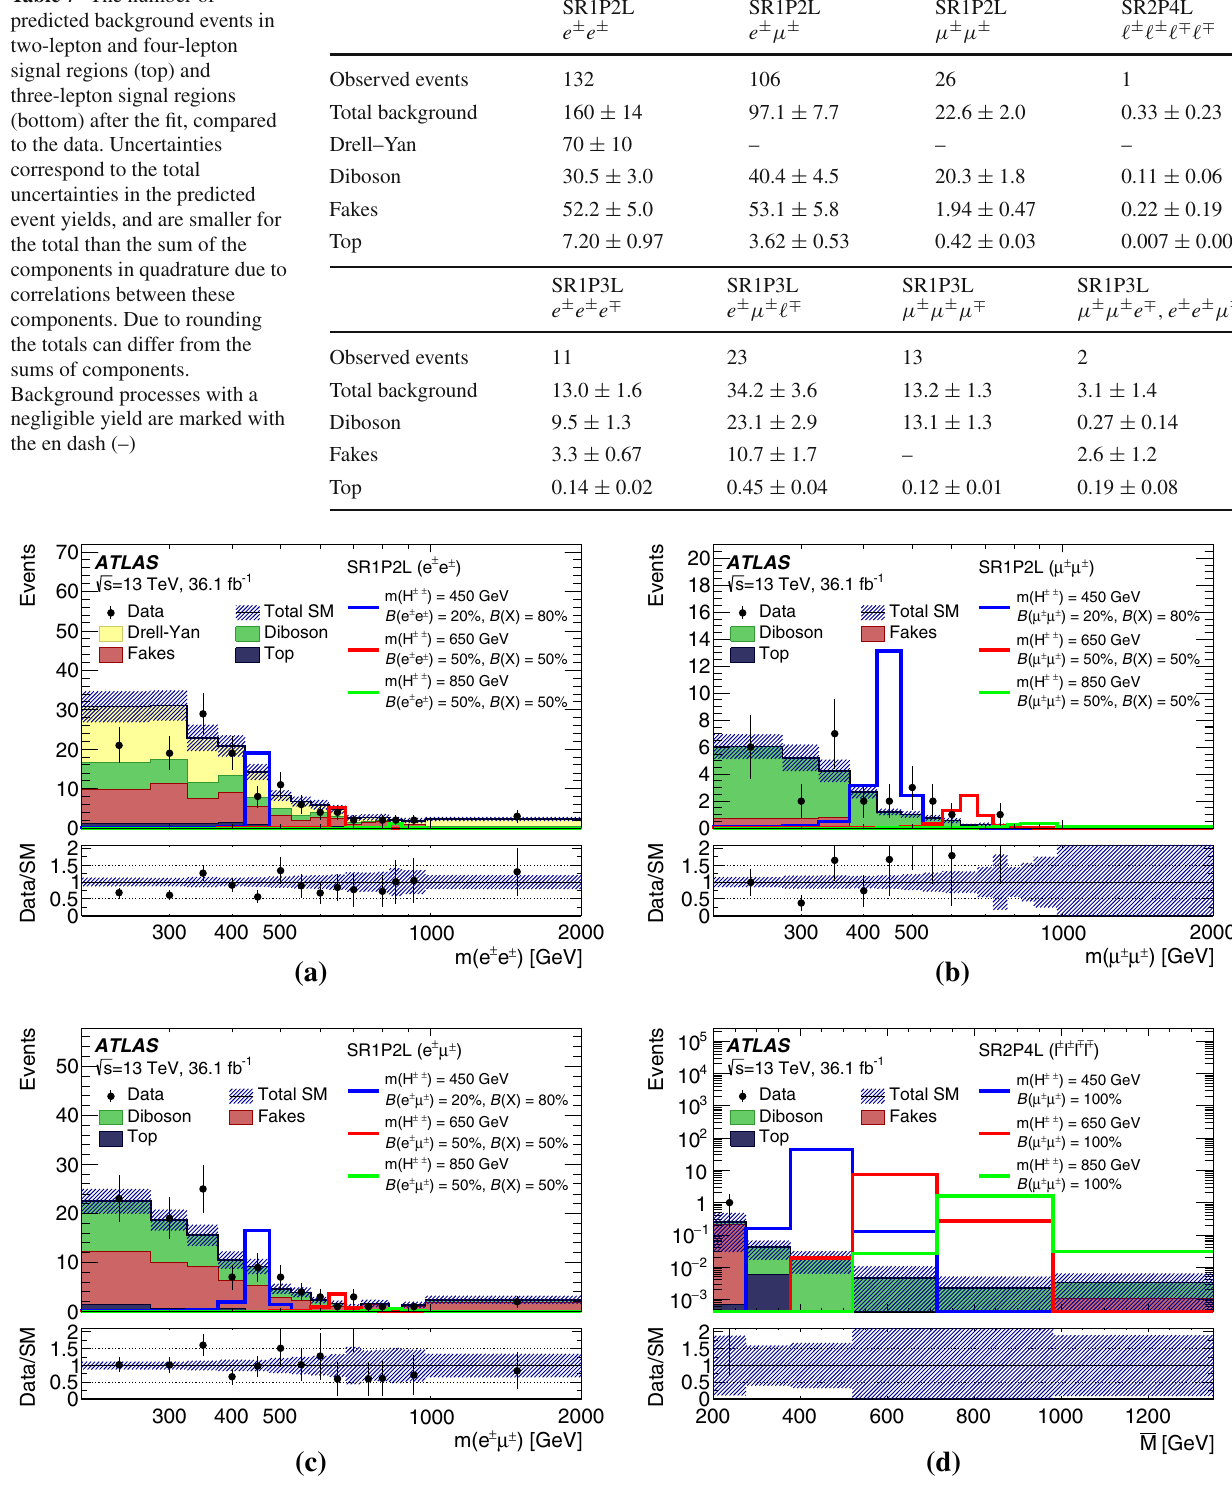
Fig. 8 Distributions of m ((cid:3) ± (cid:3) ± ) in representative signal regions, namely a the electron–electron two-lepton signal region (SR1P2L), b the muon–muon two-lepton signal region (SR1P2L), c the electron– muon two-lepton signal region (SR1P2L), and d the four-lepton signal region (SR2P4L). The hatched bands include all systematic uncertain-